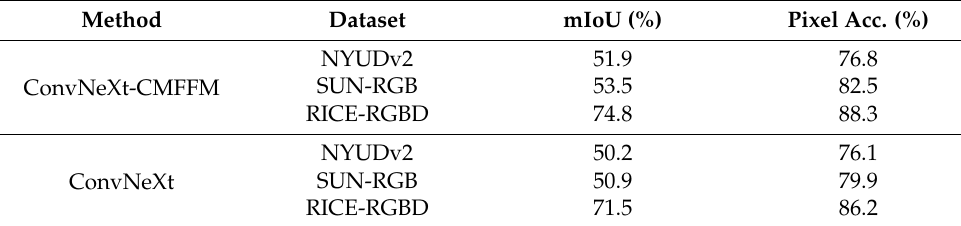
Table 4. Comparison results.